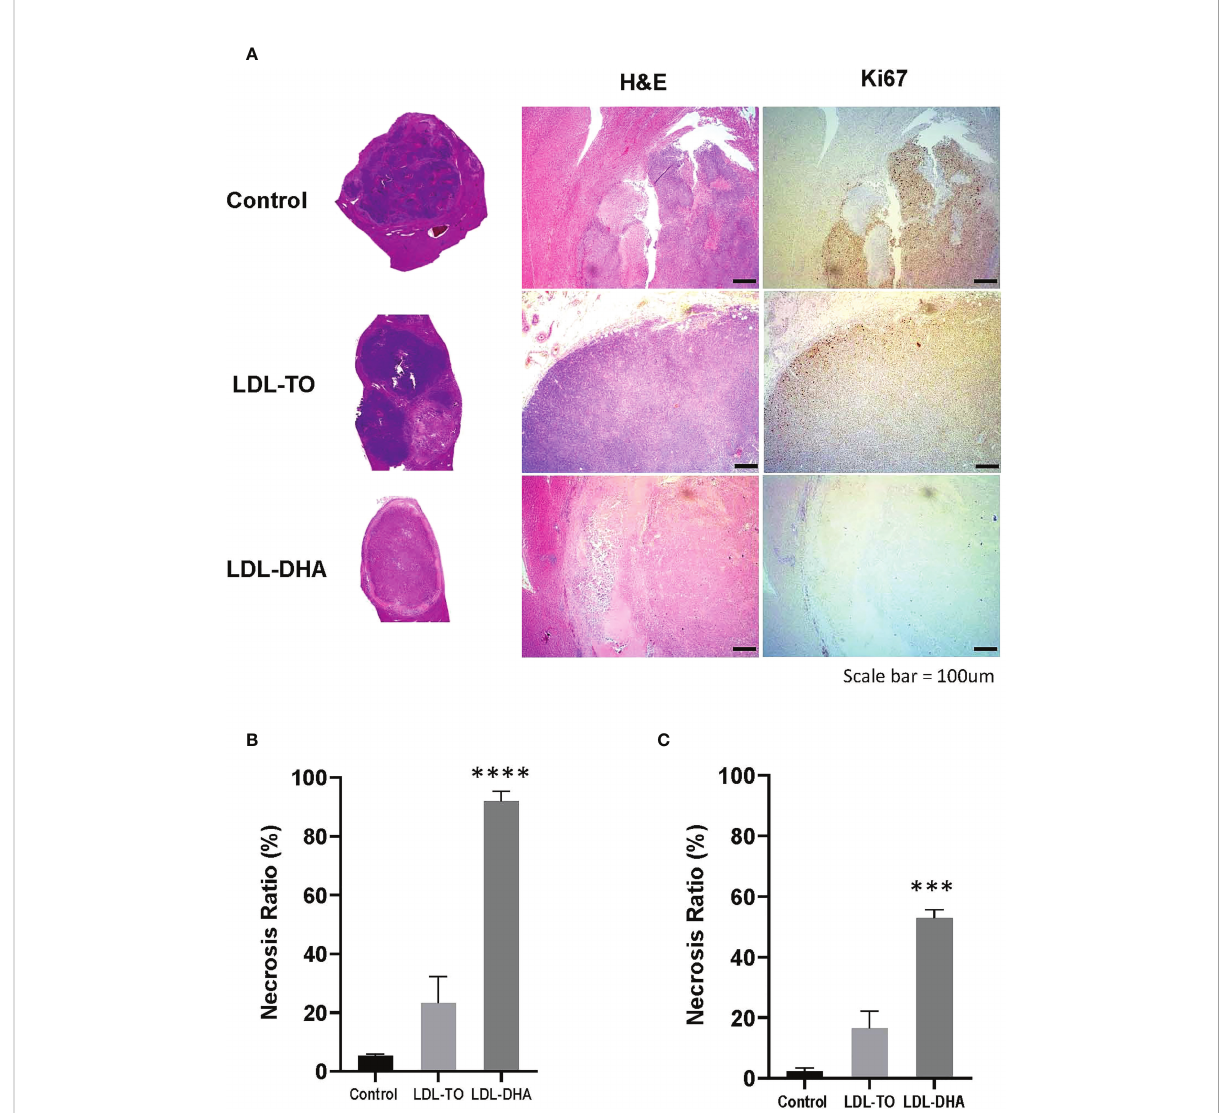
FIGURE 5 Tumor Viability following repeated LDL nanoparticle treatments. (A) Liver histology and immunohistochemistry of untreated controls and rats receiving repeated HAI of LDL nanoparticles. Gross tissue micrographs, hematoxylin and Eosin histological sections, corresponding IHC sections stained for stained for the proliferation marker Ki-67 and the apoptosis marker cleaved caspase-3. Images were taken at 20x magni fi cation. Dotted line indicates liver tumor boundary. The LDL-TO sections are entirely composed of tumor tissue. Necrosis ratio measurements sub fi gure 5B and 5C. Necrosis ratio is de fi ned as the volume of tumor necrosis over that of the entire tumor volume x 100%. (B) Necrosis estimates from histopathology. (C) Necrosis estimates from T1 weighted MRI. See Methods for details. Data is expressed as % mean ± SEM. ***, P<0.001; ****, P< 0.0001 versus untreated or LDL-TO